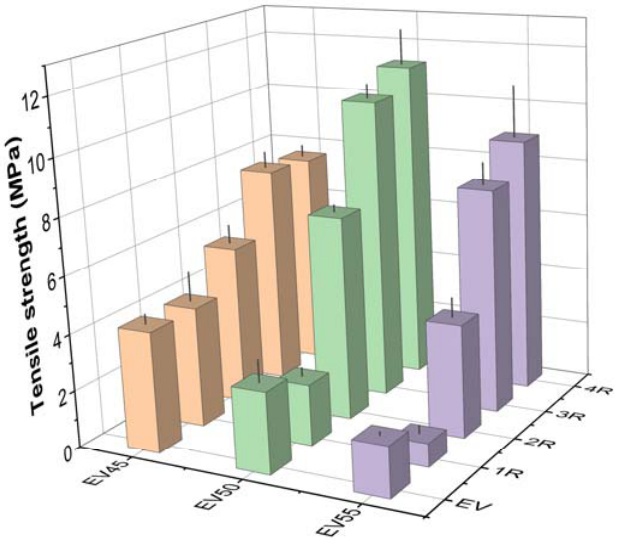
Figure 12. Tensile strength of the original and recycled epoxy vitrimers.